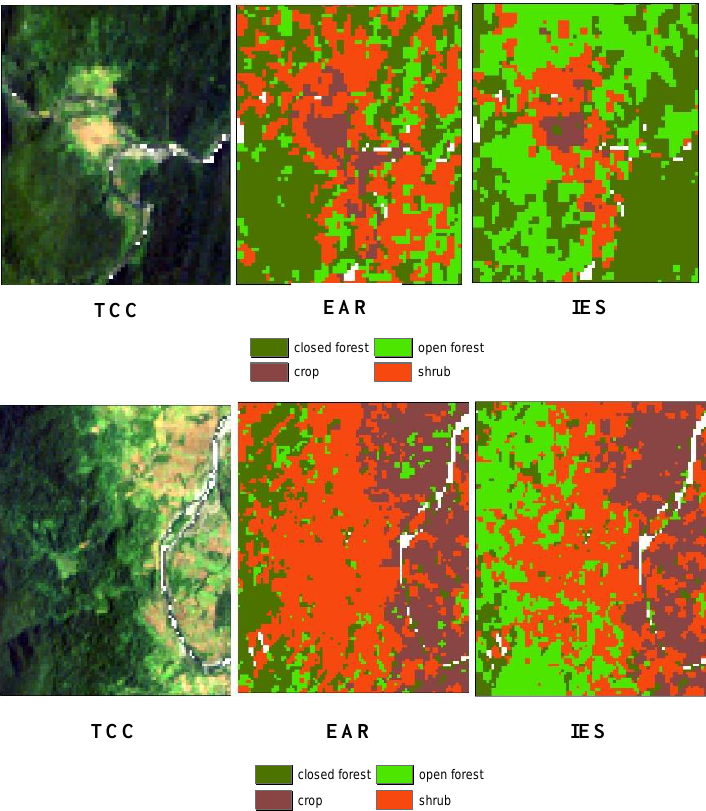
Figure 7. Comparison of true color composite and classification of the image using EAR and IES